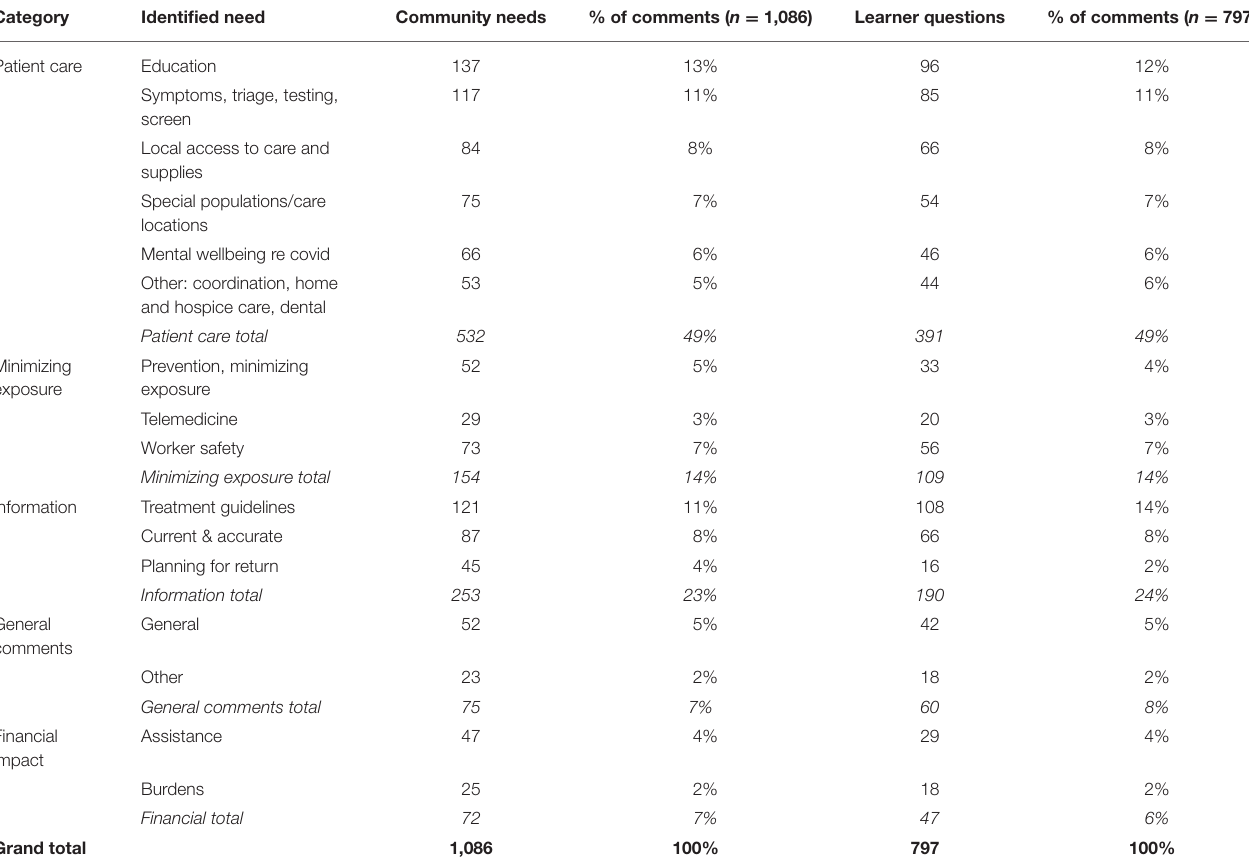
TABLE 2 | Thematic